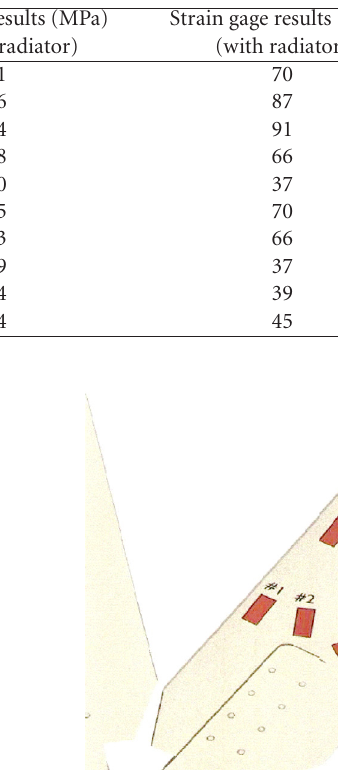
Table 1: Comparison of maximum stresses present in a fan blade at steady state.